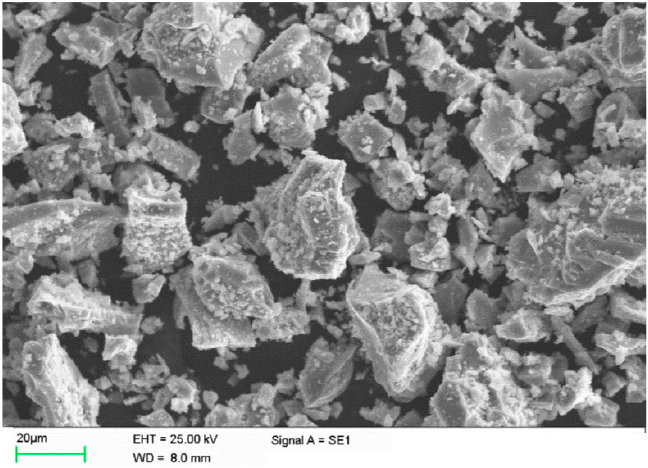
Figure 1. SEM micrographs of the powders under study.